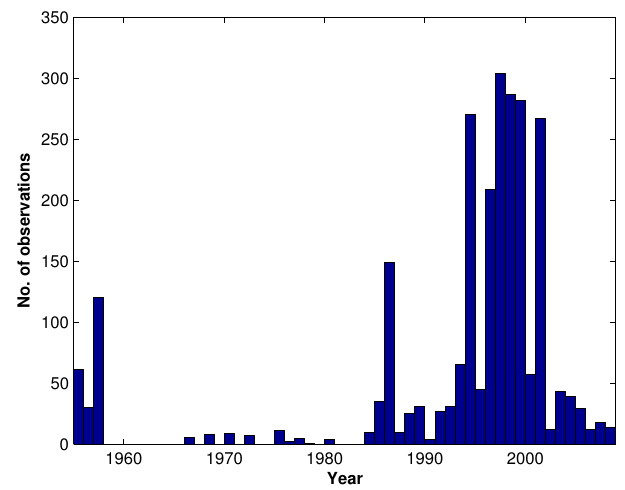
Figure 4. Number of observations for Phaeocystis species per year, Fig. 4. Number of observations for Phaeocystis species per year, for the years 1950–2009. Most counts for the years 1950–2009. Most counts were made after 1990. were made after 1990.